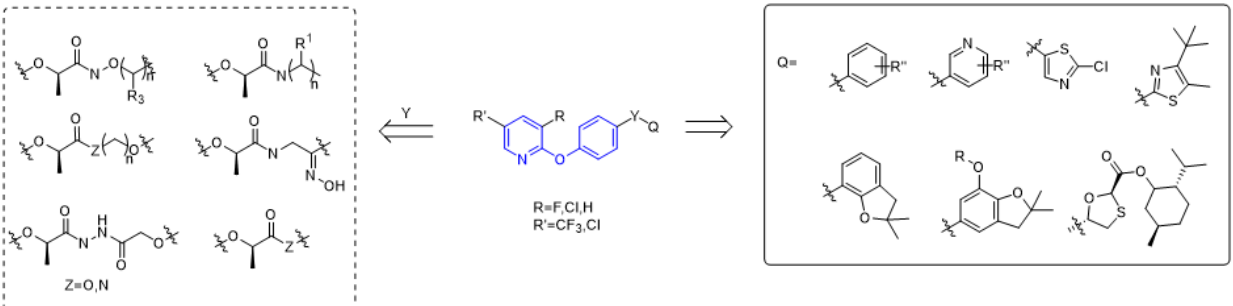
Figure 2. The general structural formula of ACCase inhibitors.